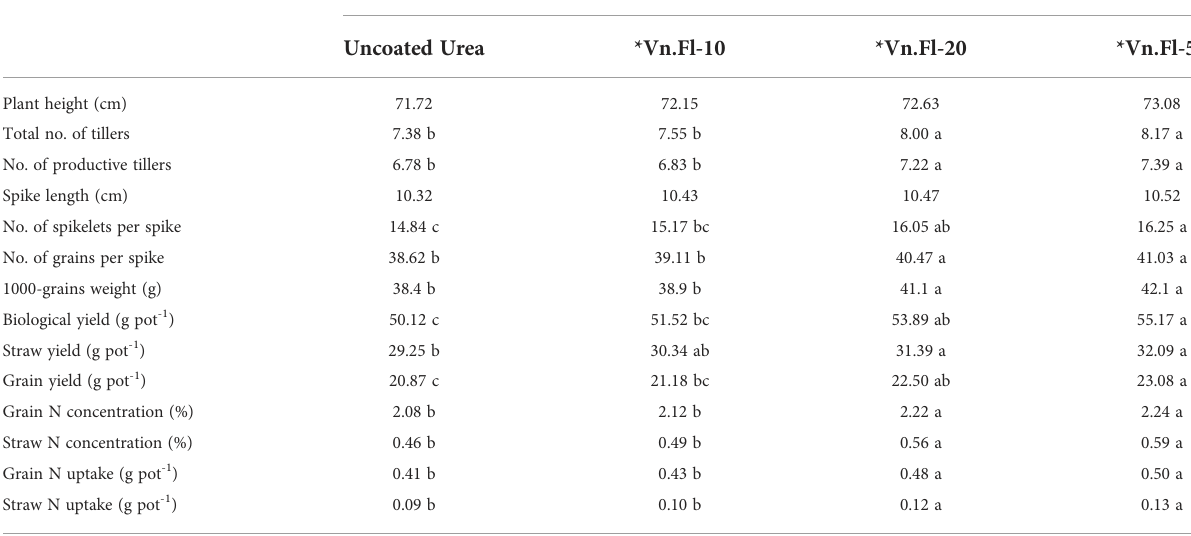
TABLE 2 The growth, yield, and N status of wheat supplied with different rates of Vachellia nilotica extract coated urea in pot experiments.